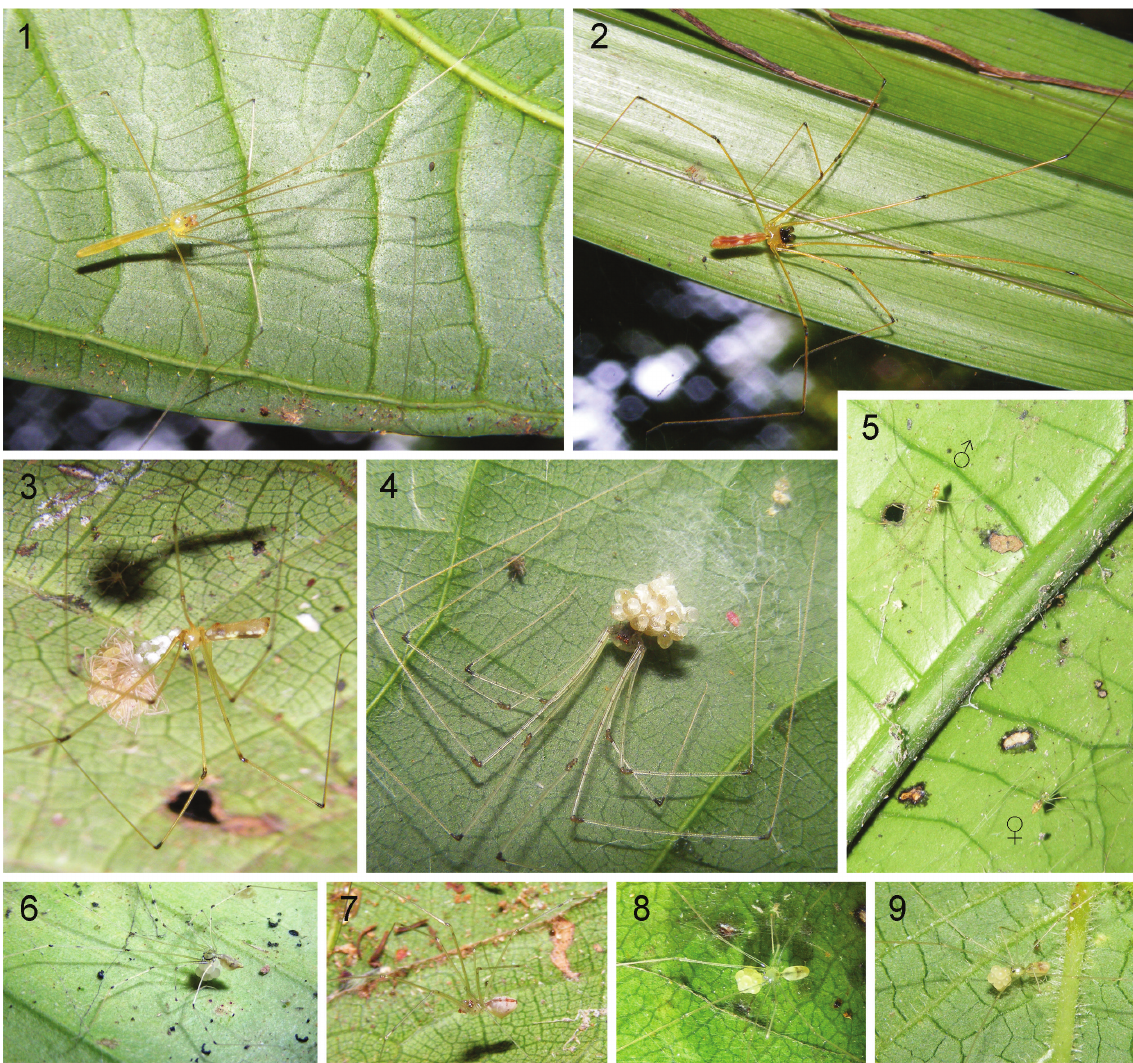
Figs 1-9. Leaf-dwelling Central African pholcids. 1 . Leptoholcus gabonicus sp. nov., ♂ from Mayebout, Gabon. 2-3 . Pholcus baka Huber, 2011, ♂ from Sahoué (2) and ♀ with juveniles from Mayebout (3), Gabon. 4 . Smeringopus cylindrogaster (Simon, 1907), ♀ with eggsac from Loum, Cameroon. 5-6 . Spermophora awalai sp. nov., pair from Nyasoso (5) and a ♀ with eggsac from Attuleh (6), Cameroon. 7 . Spermophora akwamu Huber & Kwapong, 2013, ♀ from NE Makokou, Gabon. 8-9 . Quamtana